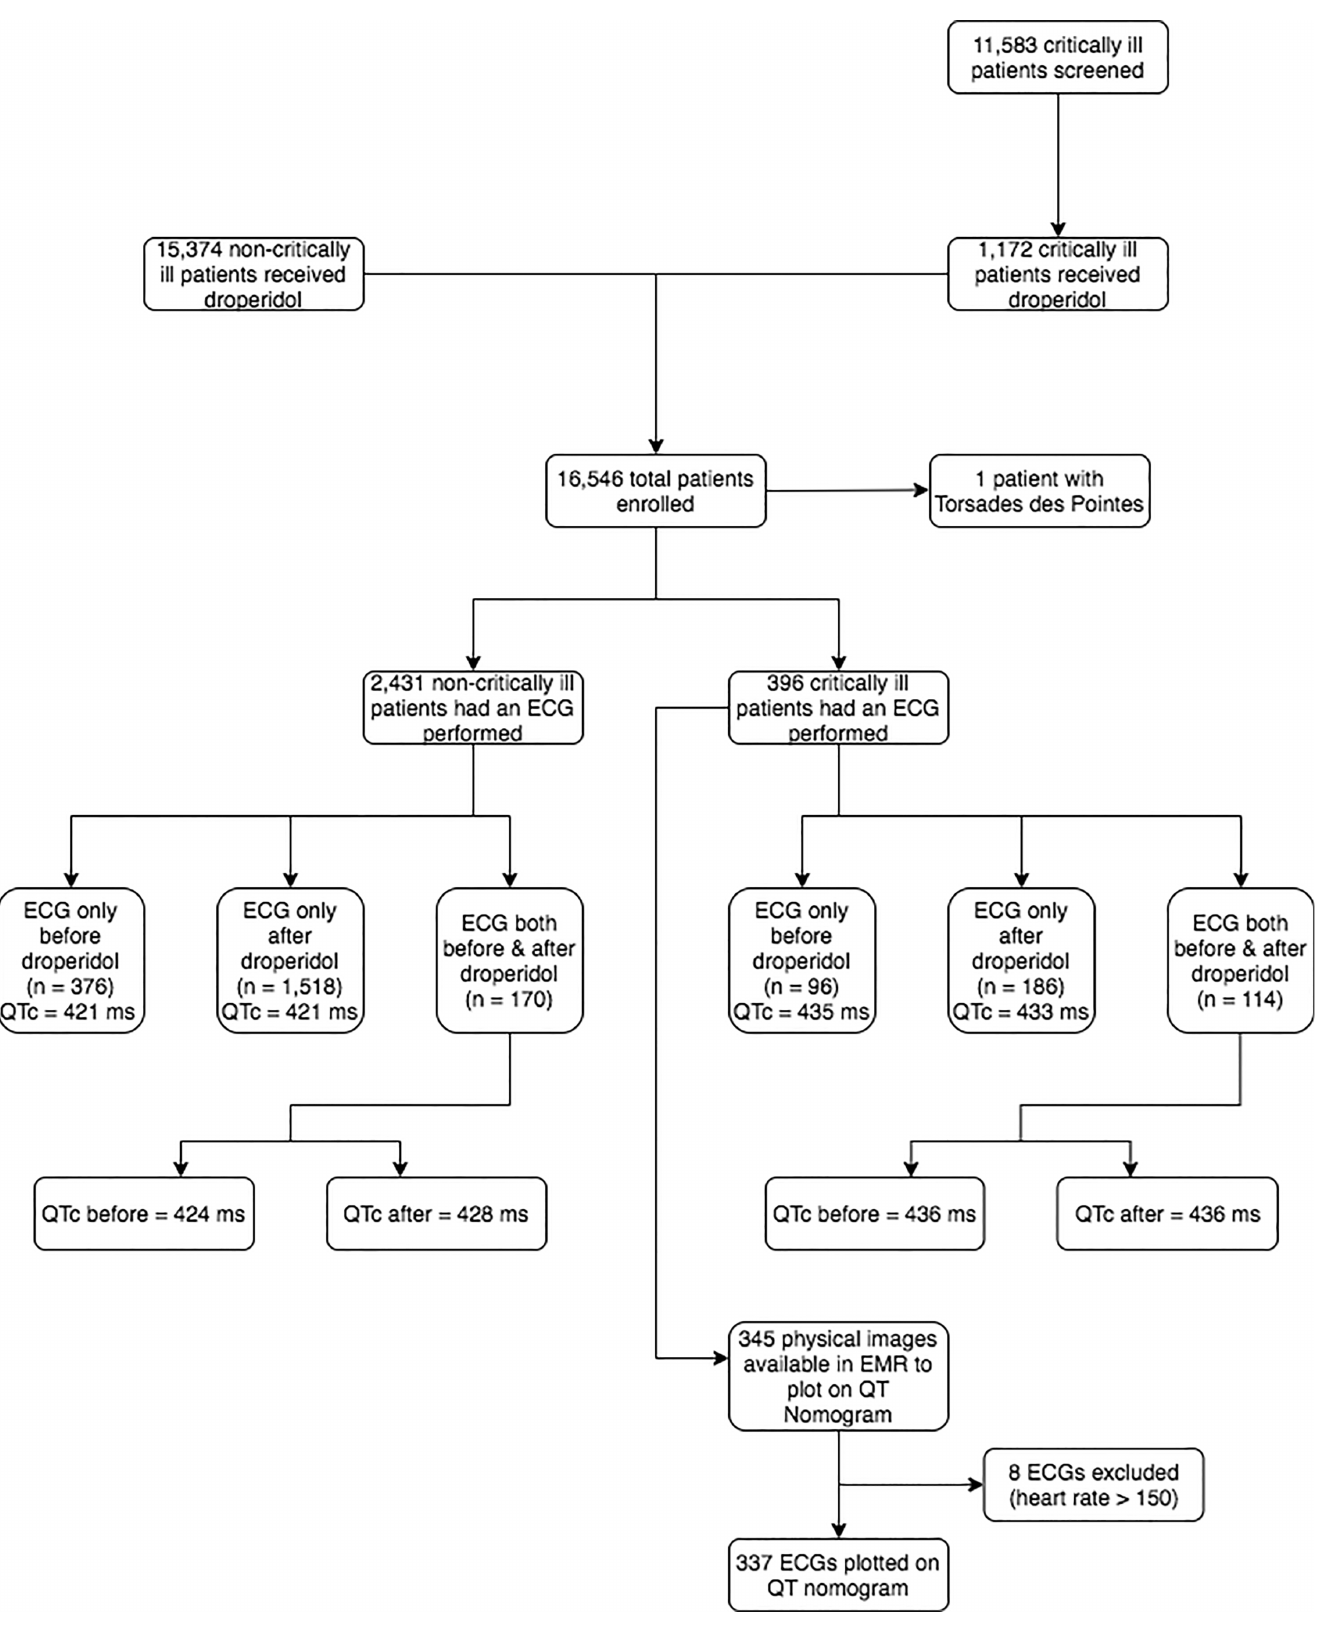
Figure 1. Study enrollment. QTc values, in milliseconds, in each box represent a mean value. ECG, electrocardiogram; EMR, electronic medical record; QTc, corrected QT interval; ms,